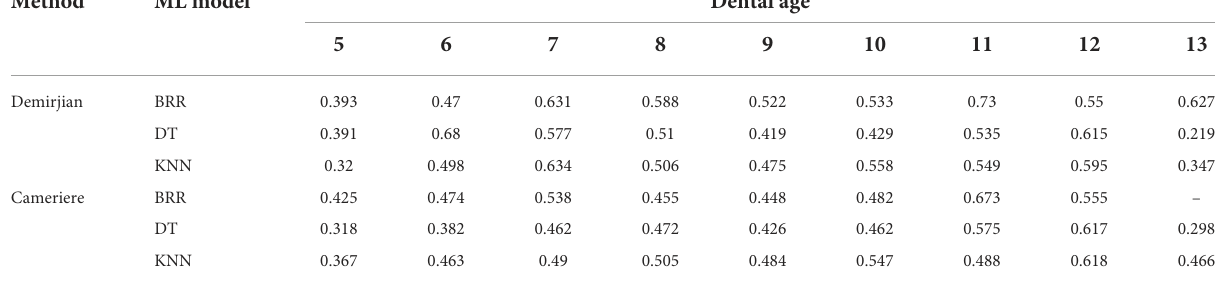
TABLE 3 Typical absolute error, in dependency of dental age for different situations.